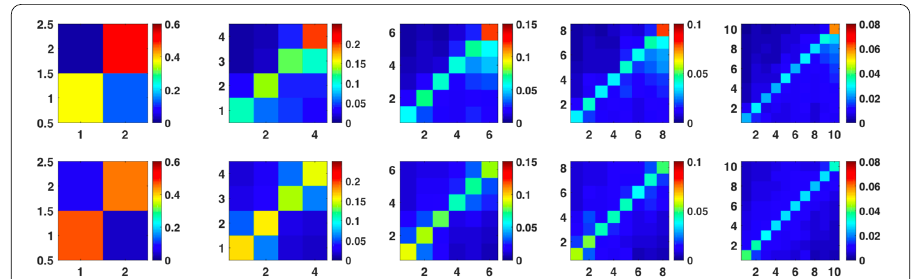
Figure 14 Mixing matrices of (Top) purchase and (Bottom) Twitter mention networks for extreme neighborhoods in terms of socio-economic status group for the European metropolitan area. The columns from left to right correspond to the consideration of 1, 2, 3, 4 and 5 extreme groups on both the low and high socio-economic distribution